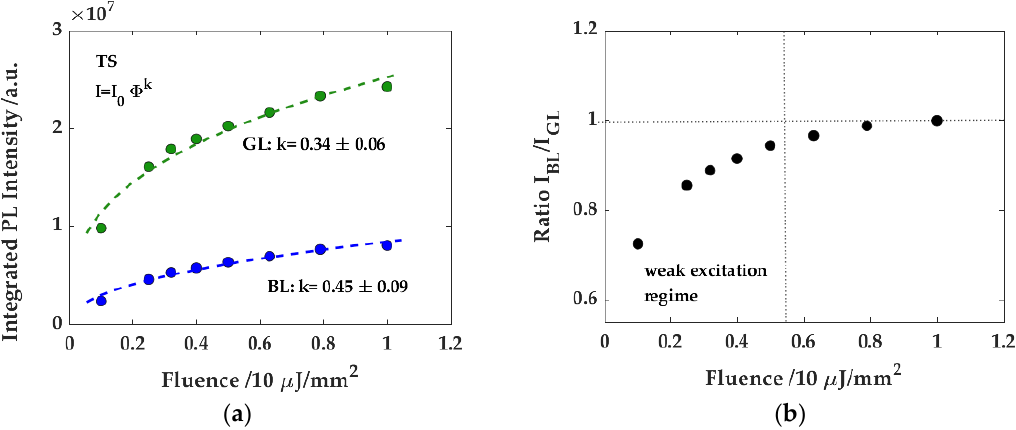
Figure 3. ( a ) Dependence of the trap-assisted blue luminescence (BL) and green luminescence (GL) emission intensity on the excitation fluence in sample ZW1. The integrated photoluminescence (PL) intensities are interpolated with a power function of the excitation fluence. The estimated k coefficient of the power law is reported. ( b ) The normalized ratio between the integrated photoluminescence intensity of BL and GL emission as a function of the fluence.